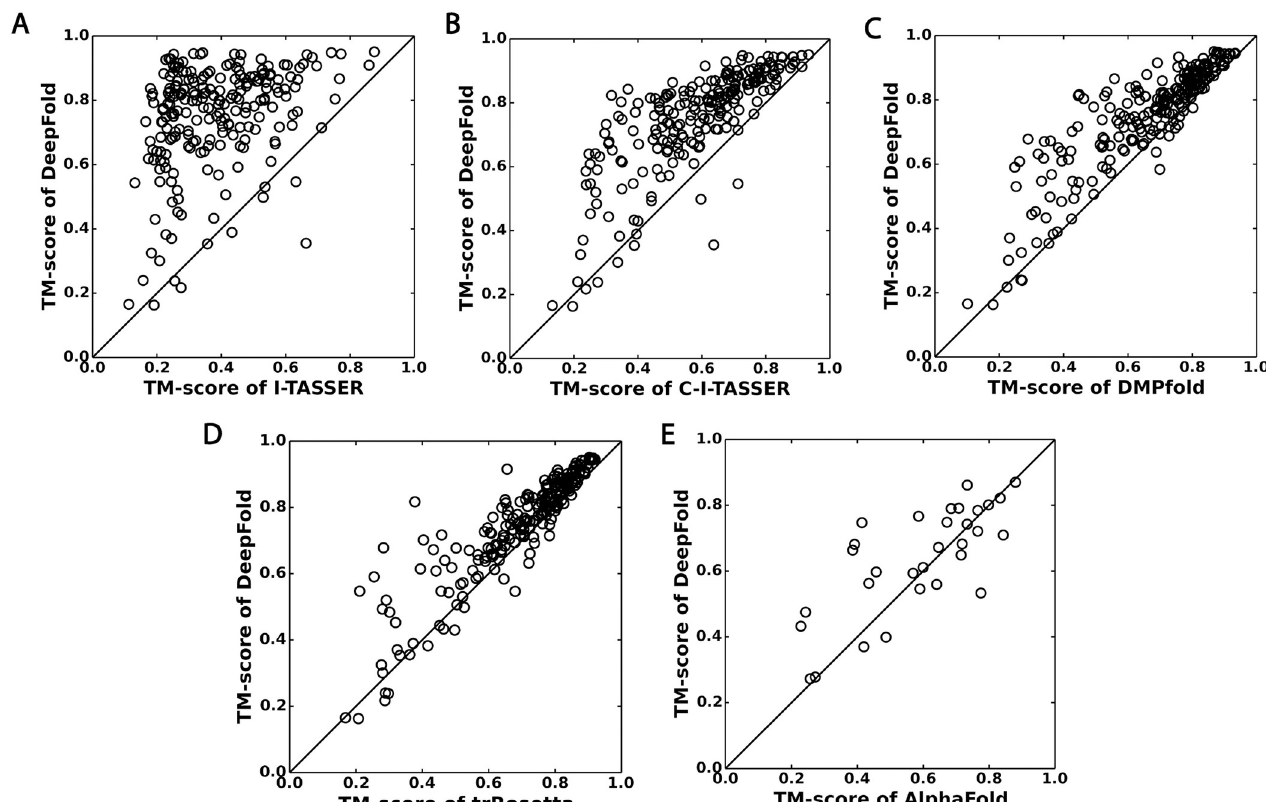
Fig 4. Head-to-head TM-score comparisons between DeepFold and other protein structure prediction methods: A) I-TASSER; B) C-I-TASSER; C) DMPfold; D) trRosetta; E) AlphaFold. (A-D) are based on the 221 Hard benchmark proteins, while (E) is on 31 FM targets from CASP13.